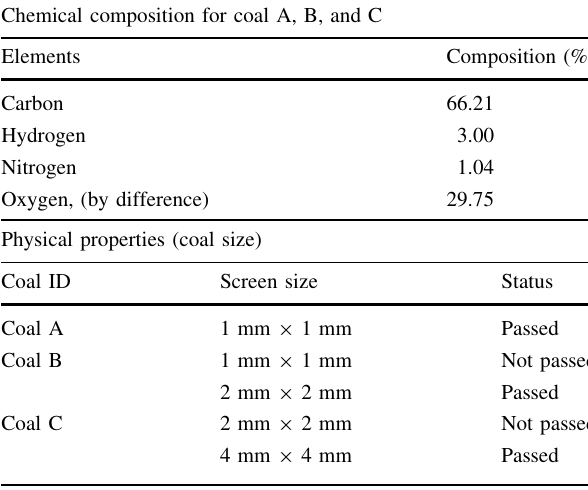
Fig. 3 Thermocouples position in the coal bed area from top and side views Table 1 Gas sensor specification Table 2 The chemical and physical properties of charcoal Chemical composition for coal A, B, and